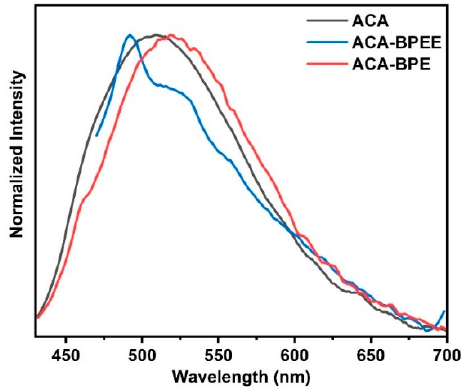
Figure 5. Solid-state photoluminescence spectra of ACA ( 𝜆 ex = 420 nm), ACA-BPEE ( 𝜆 ex = 450 nm), and ACA-BPE ( 𝜆 ex = 420